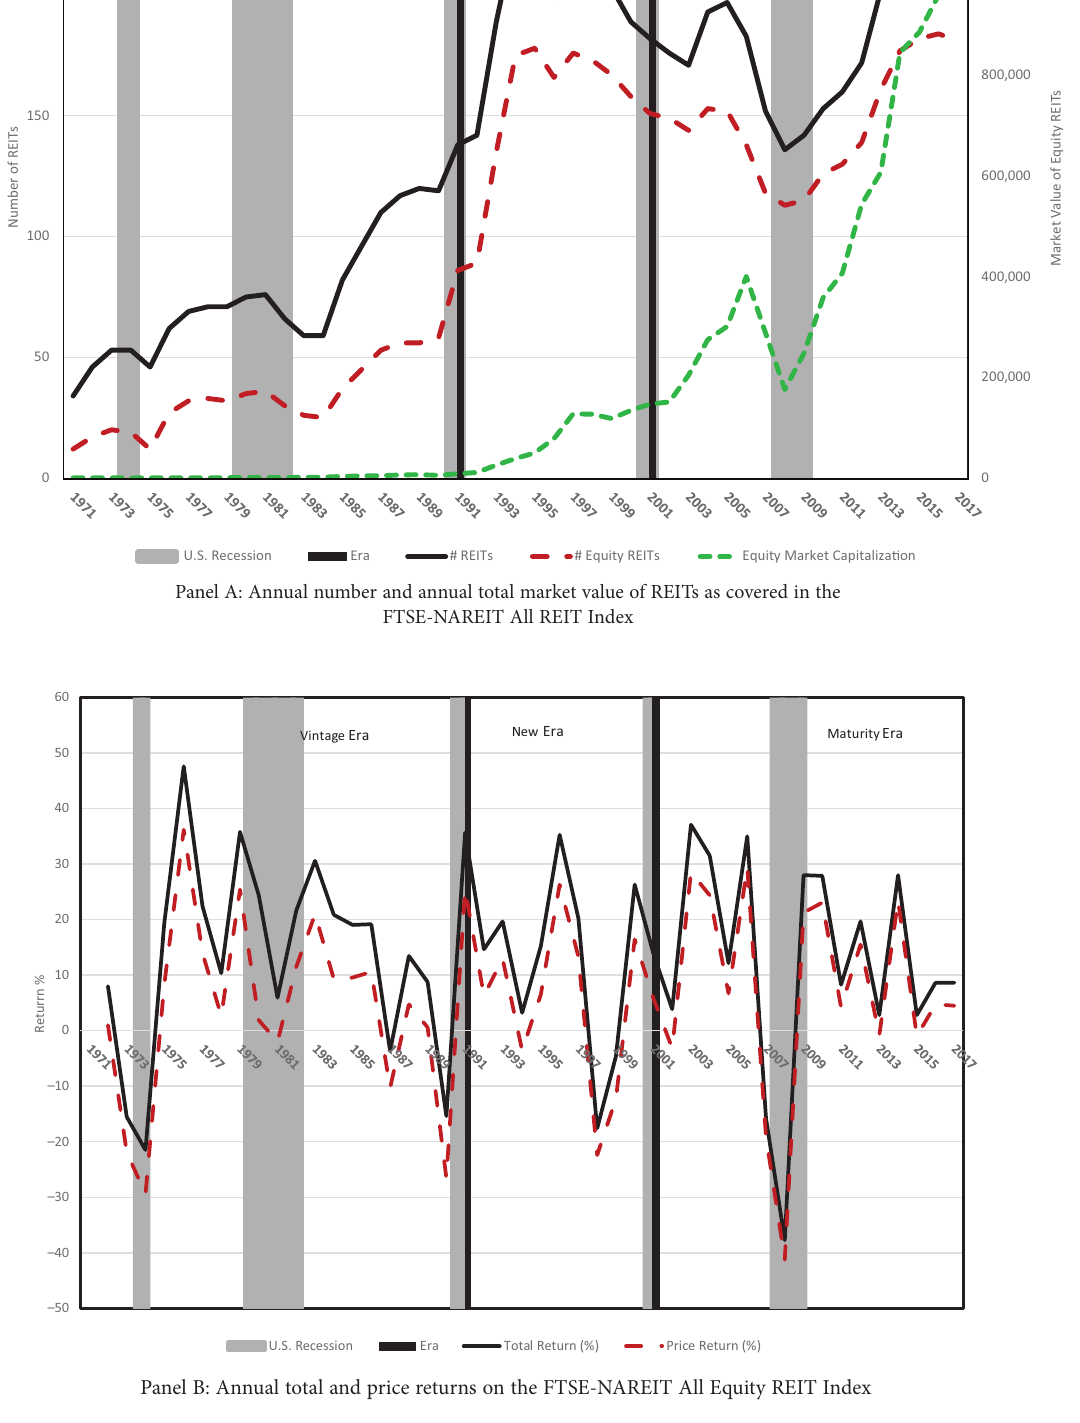
Figure 1. Evolution of the REIT industry,